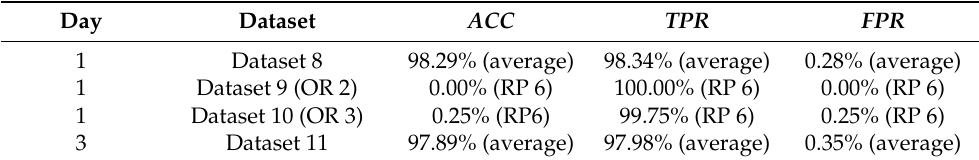
Table 2. Summary of evaluation metrics across different time periods and orientations on different RPs using AP